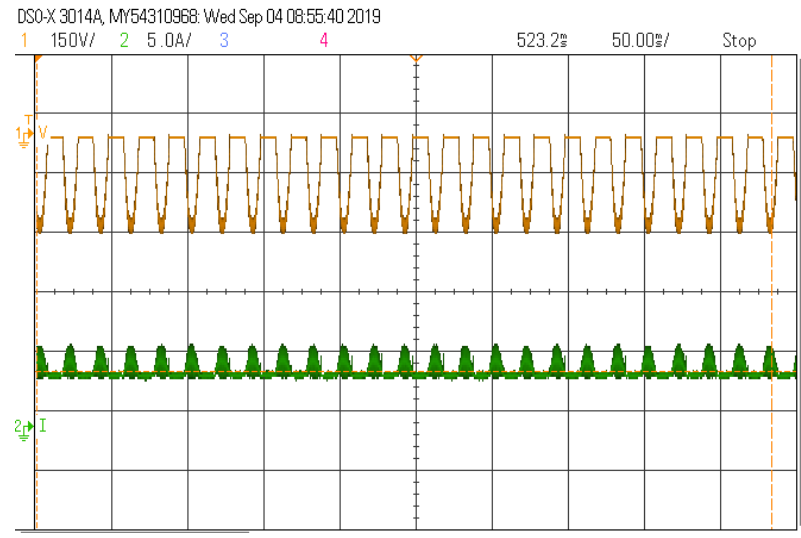
Figure 25. Voltage across and current through the Diode. Table 7. Comparison of results obtained using simulation and experimental study.